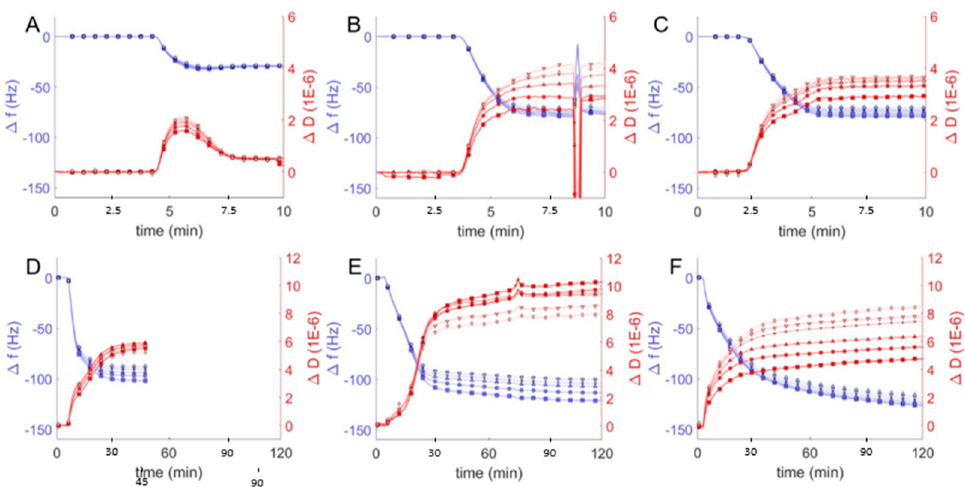
Figure 4. Frequency change ( Δ f/n , blue) and dissipation ( Δ D , red) measurements from QCM-D monitoring of hybrid polymer/lipid vesicles in Tris buffer (pH = 2) interacting with plasma cleaned borosilicate glass, showing data from the 3rd through 13th harmonics, 3rd ( □ ), 5th ( ○ ), 7th ( ∆ ), 9th (+), 11th (inverted triangles), 13th ( ◊ ). After establishing a baseline buffer solution measurement, vesicles composed of 100 mol % DOPC ( A ) and EO 22 Bd 33 in varying amounts: 10 ( B ), 25 ( C ), 50 ( D ), 75 ( E ), 100 ( F ) mol % were introduced into the sample QCM-D sample chamber. The spurious peaks in Δ f/n and Δ D at ~8 min in (B) are due to an air bubble which passed through the QCM-D chamber.